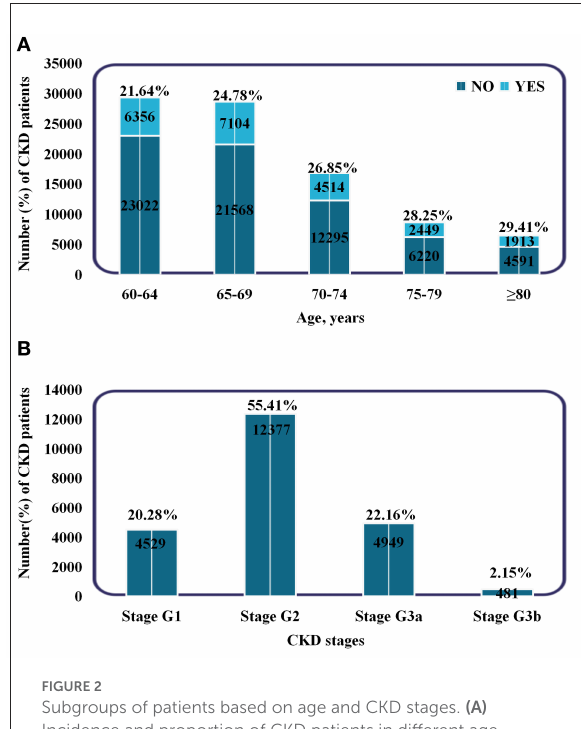
FIGURE2 Subgroups of patients based on age and CKD stages. (A) Incidence and proportion of CKD patients in different age groups. (B) The number and proportion of patients in different CKD stages. Stage G1: eGFR ≥ 90 ml/min/1.73 m 2 . Stage G2: